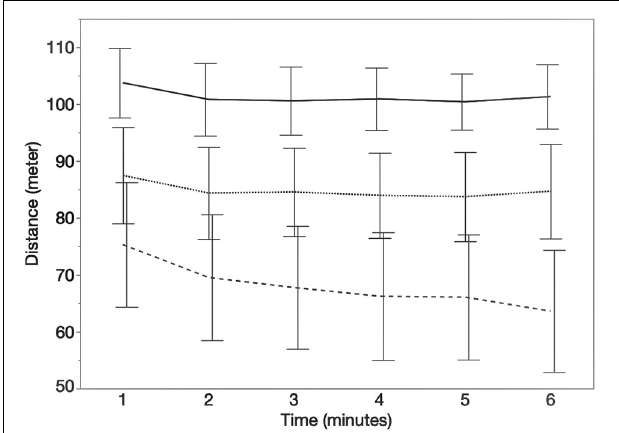
FIGURE 3 | Course of the distance (meters) walked each minute during the 6MWT. Error bars represents 95% confidence intervals. Stripe pattern line represents persons with MS with walking fatigability (WF), dotted line represents persons with MS without walking fatigability (NWF) and solid line represents healthy controls (HC).